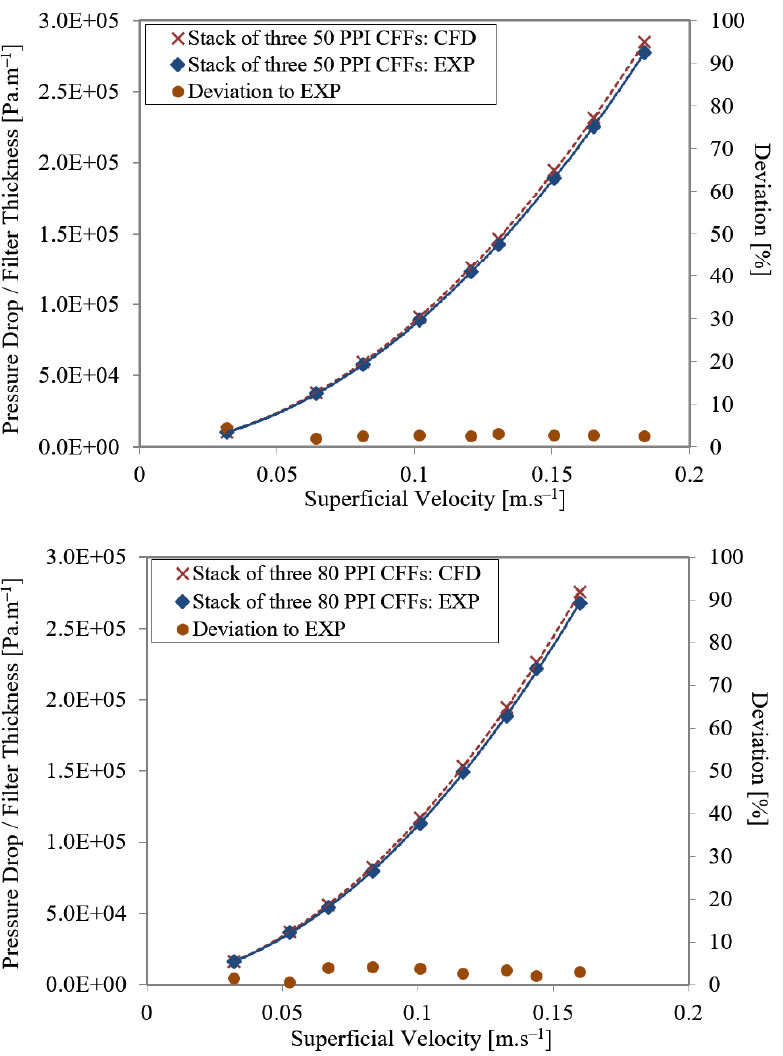
Figure 8. Comparison between the experimentally obtained (the solid curves) and the CFD estimated (the dotted curves) pressure gradients of the well-sealed stacks of three 30, 50 and 80 PPI CFFs.